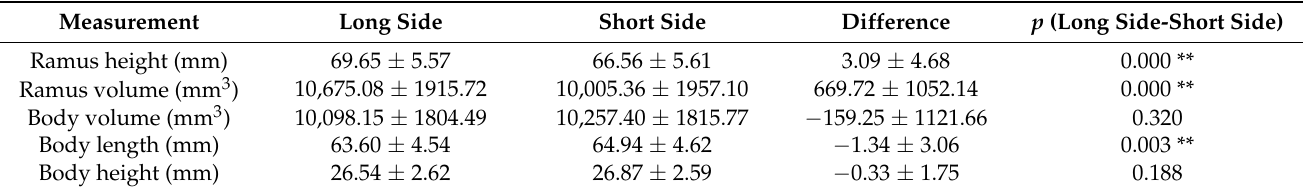
Table 4. Comparison of the mandibular morphology on both sides after surgery (T1) in patients with asymmetric mandibular prognathism.